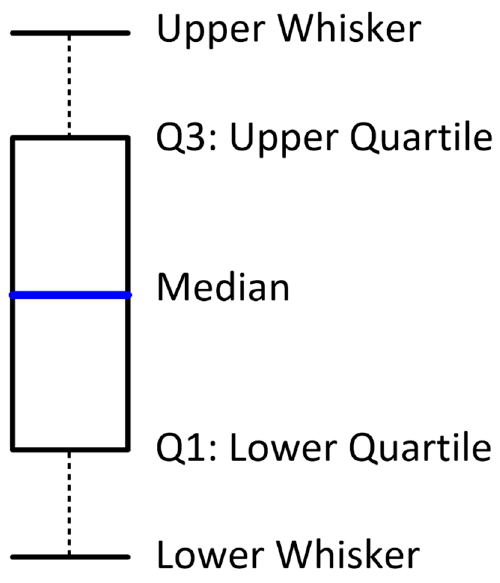
Figure 6. Box and Whisker Plot.